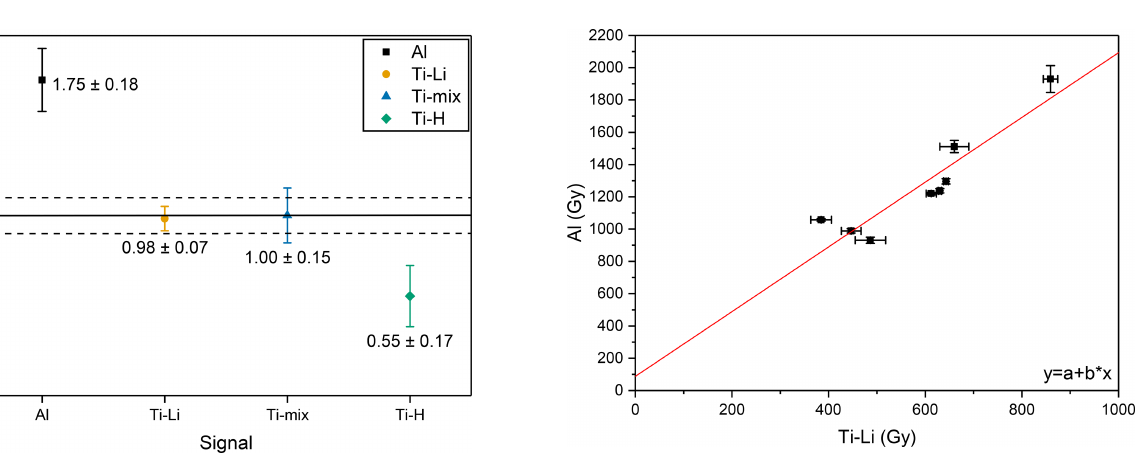
Figure 4. Dose recovery ratios. The dashed lines mark the 10% deviation margin.